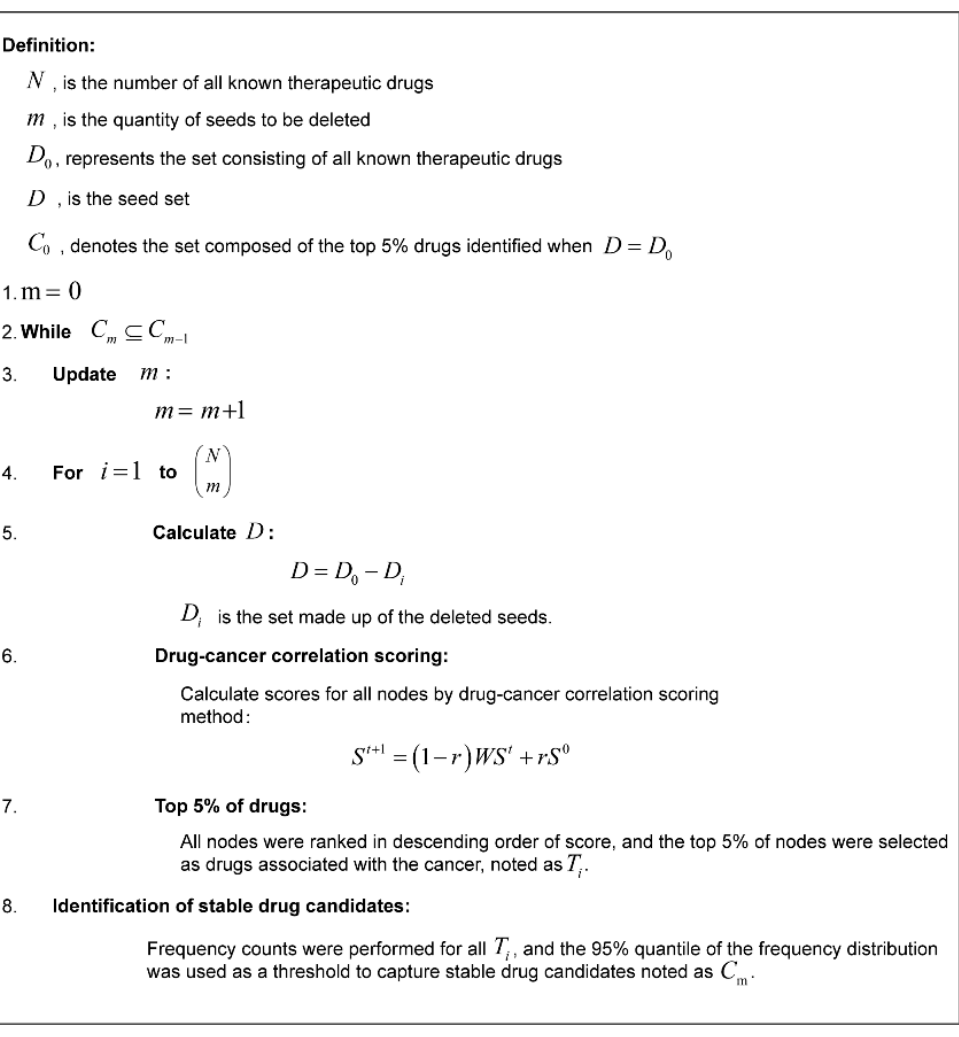
Figure 8. Pseudo-code for stable drug candidate identification.